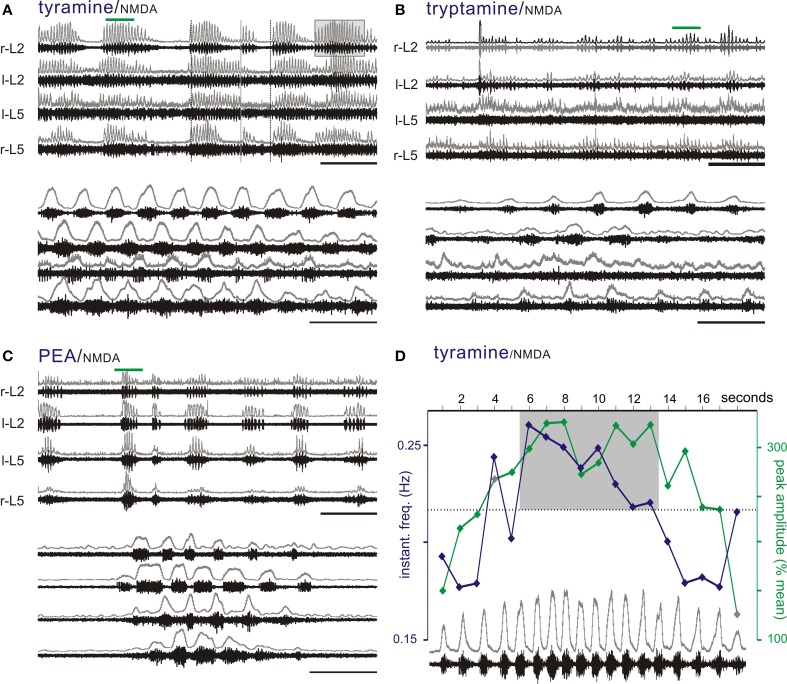
The TAs produce episodic bursting patterns that are different than the regular pattern seen with 5-HT in the presence of NMDA. (A–C) Tyramine, tryptamine, and PEA can produce episodic rhythmic motor bursting patterns with bouts of locomotor-like bursting interrupted by quiescent periods. Bottom panels are expanded time scales of time periods identified by green bars to show in detail the locomotor-like coordination. Typically, episodic bursts are concurrent on all ventral roots. (D) Episodic bouts of locomotor-like activity are frequently associated with wax and wane changes in amplitude and frequency. Shown is the bout highlighted by the box on r-L2 in panel A with overlaid plots of instantaneous frequency (blue) and peak amplitude of the rectified response (green). Note the trend for amplitude and frequency to increase then decrease over the episodic bout of locomotion. Events within the shaded box emphasize the dominance of higher frequency/higher amplitude values in the middle of the episode of bursting. The upper traces in gray at each lumbar root represent the rectified/low-pass filtered equivalent of the raw waveforms below them. Scale bars are 100 s in top panels and 10 s in bottom panels.